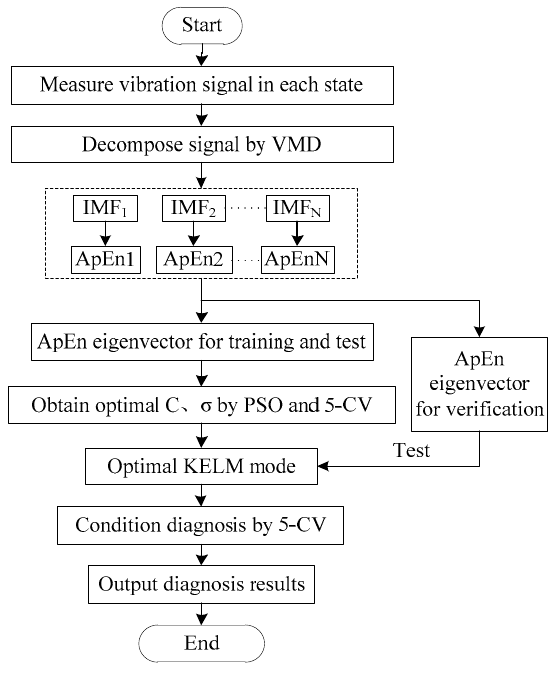
Figure 9. Fault diagnosis process. ApEn : approximate entropy; PSO: particle swarm optimization; CV: cross validation; KELM: kernel extreme learning machine.